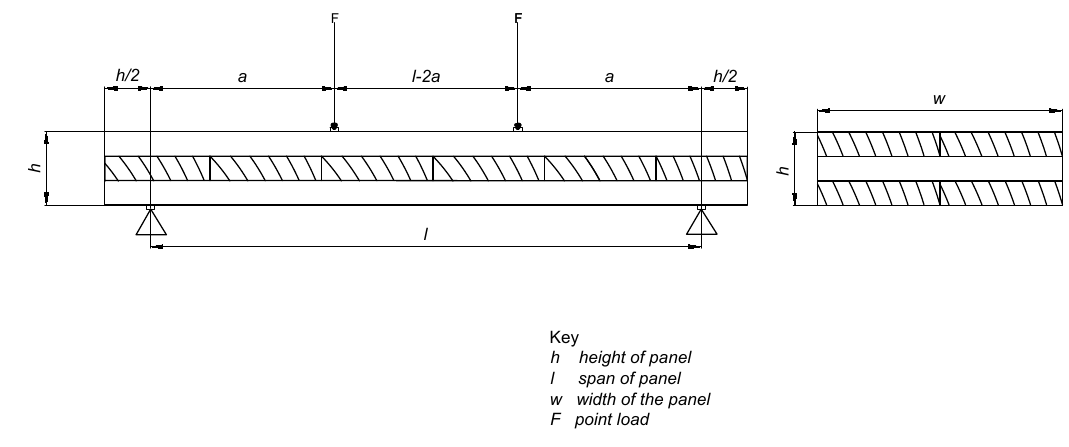
Figure 16. Illustration of four-point bending set up